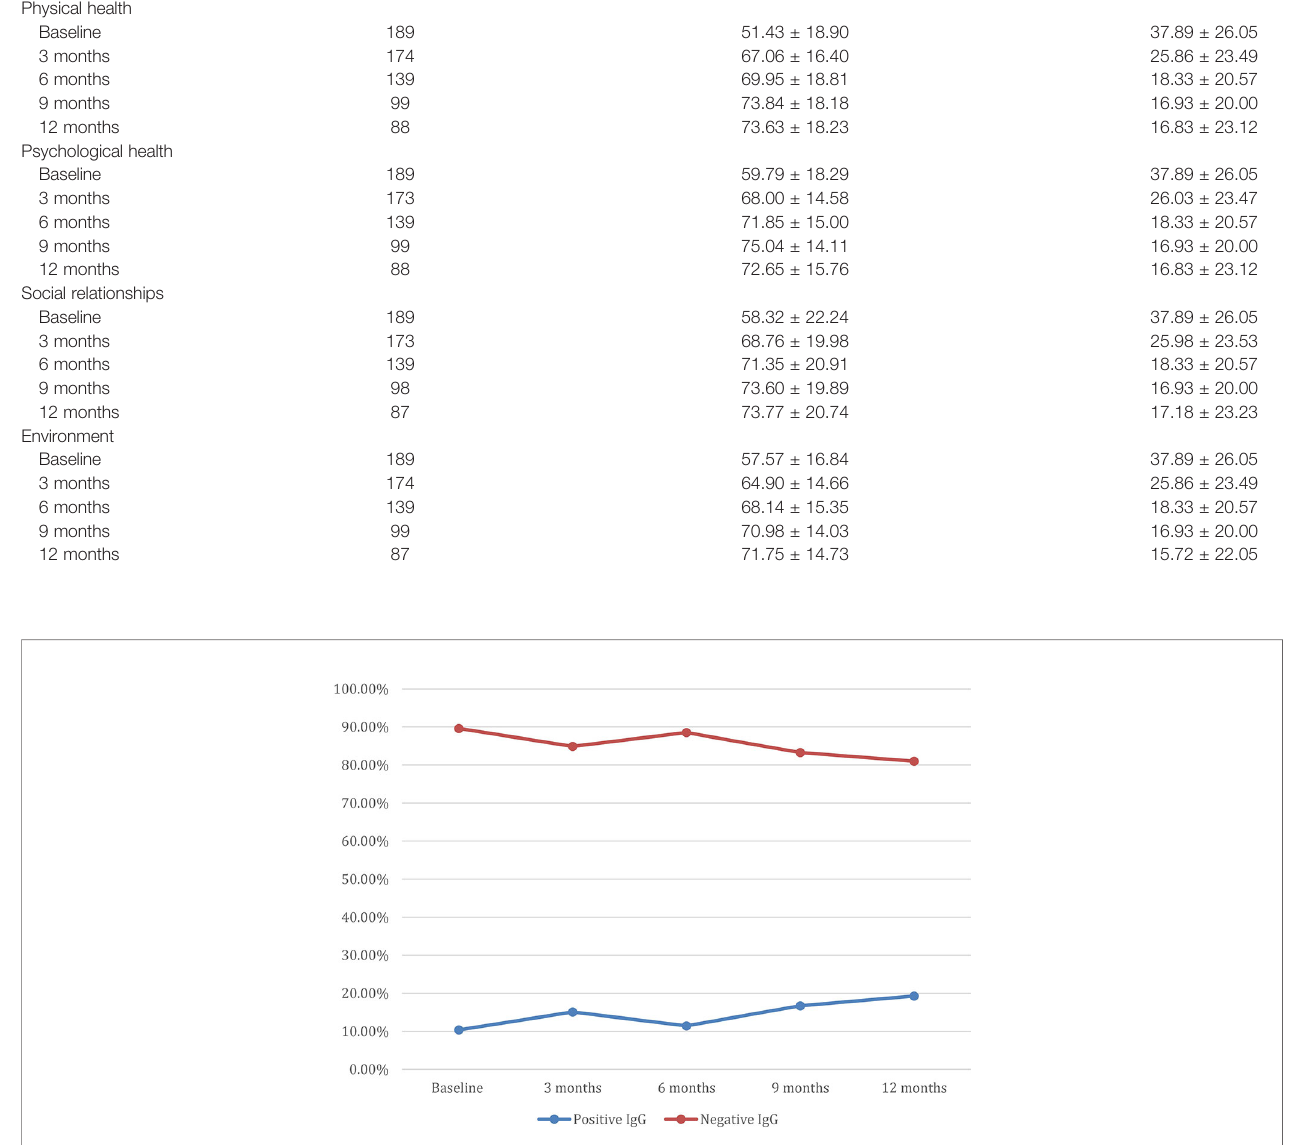
FIGURE 1 | Trends in Proportion of Aspergillus IgG being positive at different time points.